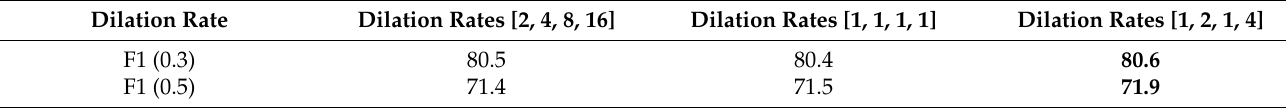
Table 5. Comparison of different dilation rate combinations. The bold scores are the best. Dilation